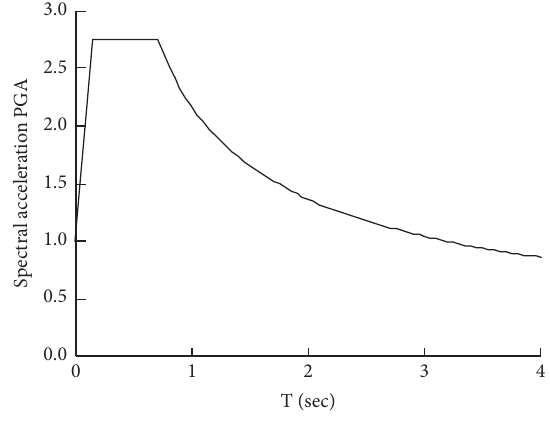
Figure 14: Spectral acceleration/PGA.